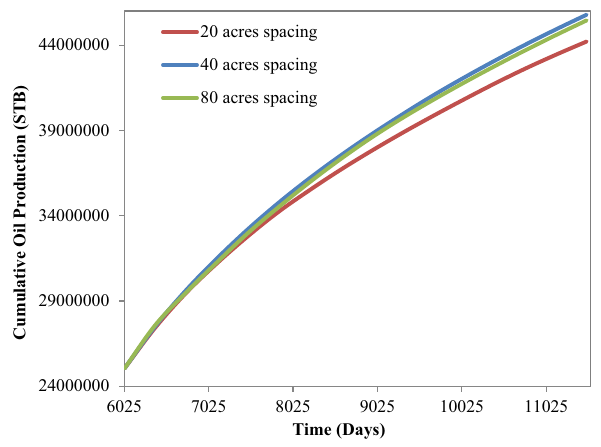
Fig. 20 Cumulative water production versus time for 4 vertical infill wells at different well spacings